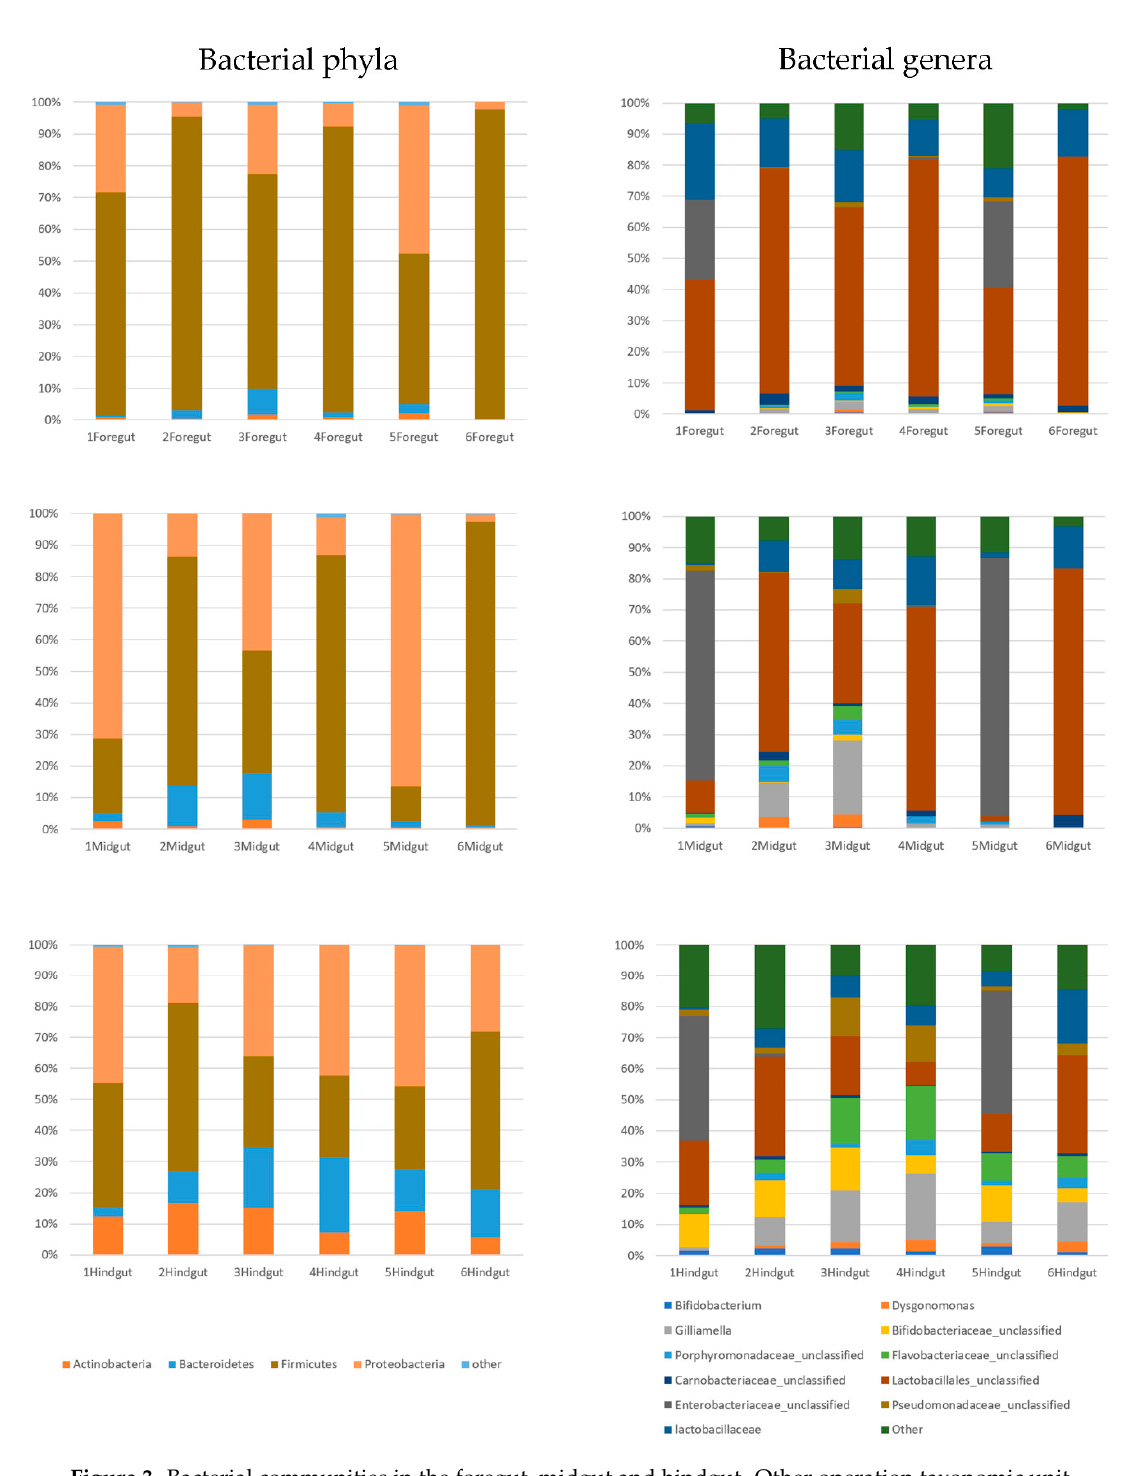
Figure 3. Bacterial communities in the foregut, midgut and hindgut. Other operation taxonomic unit (OTU) bacteria in samples with less than 2% prevalence are included as “other” category.